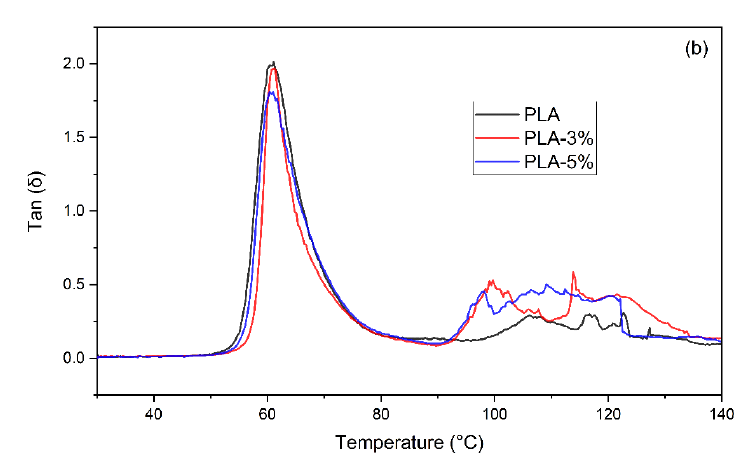
Figure 5. ( a ) Storage modulus and ( b ) tan( δ ) variation as a function of temperature of PLA, PLA-3%, and PLA-5% CaCO 3 fillers.